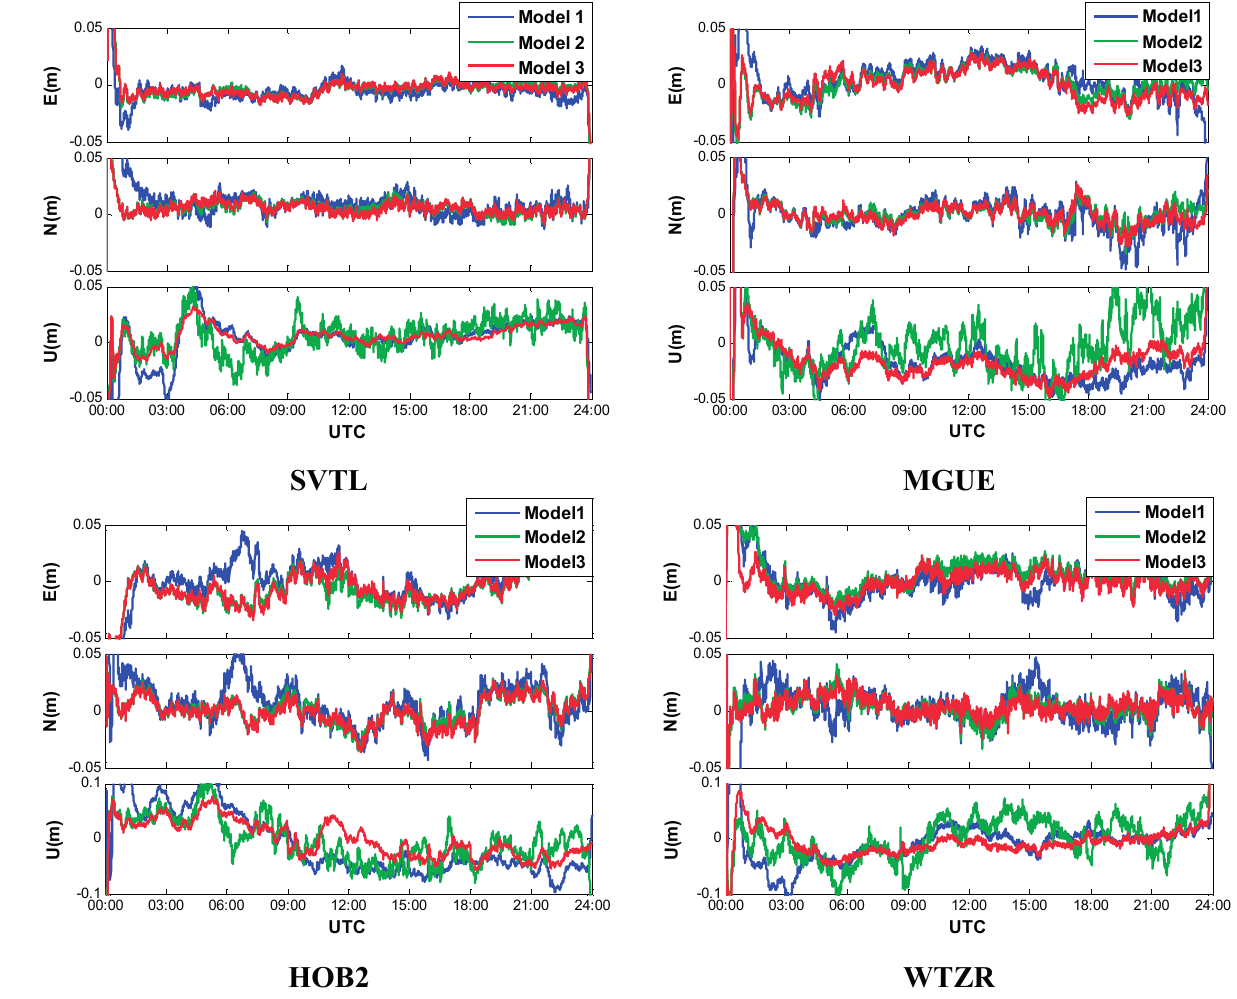
Figure 1. Positioning errors of kinematic PPP with forward Kalman filter.